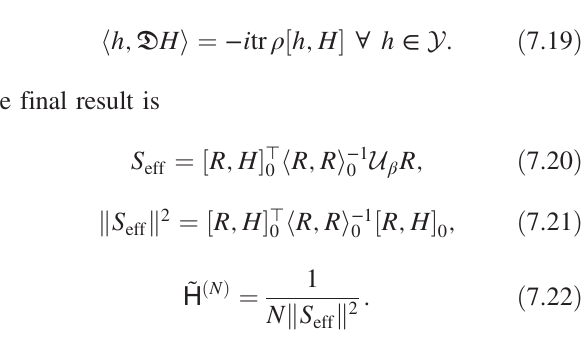
FIG. 11. A schematic of the semiparametric displacement model given by Eq.